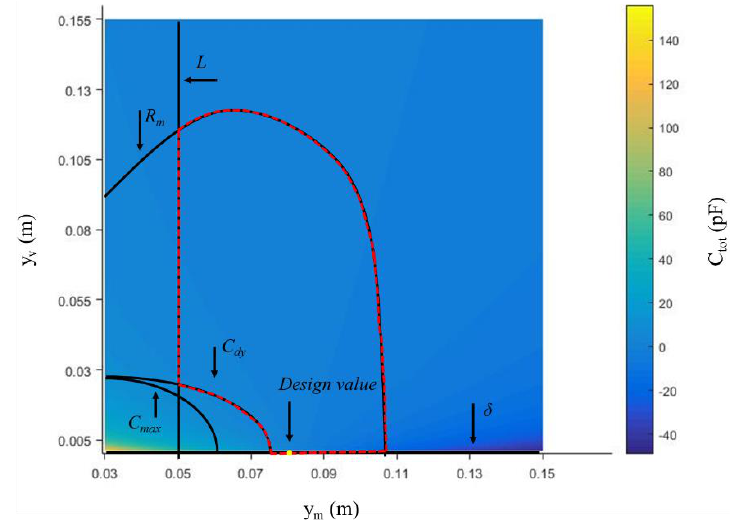
Figure 5. The distribution nephogram of sensor capacitance under different corn thicknesses and cavity wall thicknesses. Note: the filling corn moisture content was 35% w.b.